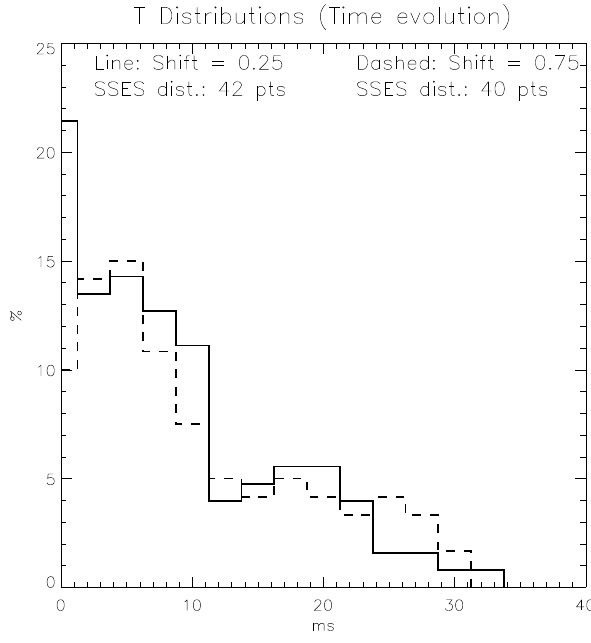
Fig. 7. Correlation time in the first (bold line) and second (dashed line) halves of the